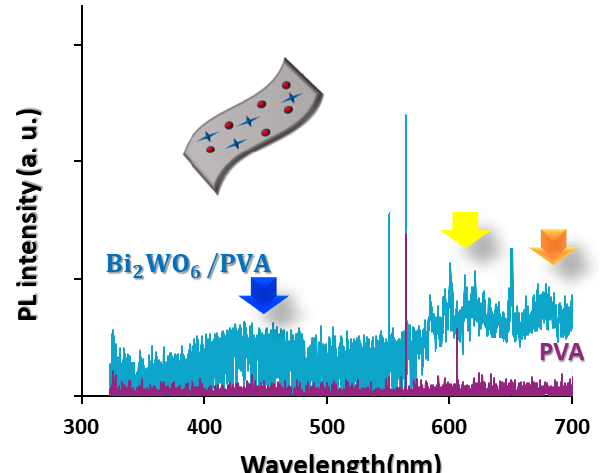
Fig. 8. Photoluminescence spectrum of the prepared flexible /PVA composite film with =290 nm at room temperature 𝐵𝐵𝐵𝐵𝐵𝐵𝐵𝐵 2 𝑊𝑊𝑊𝑊𝑊𝑊𝑊𝑊 6 𝜆𝜆𝜆𝜆 𝑒𝑒𝑒𝑒𝑒𝑒𝑒𝑒